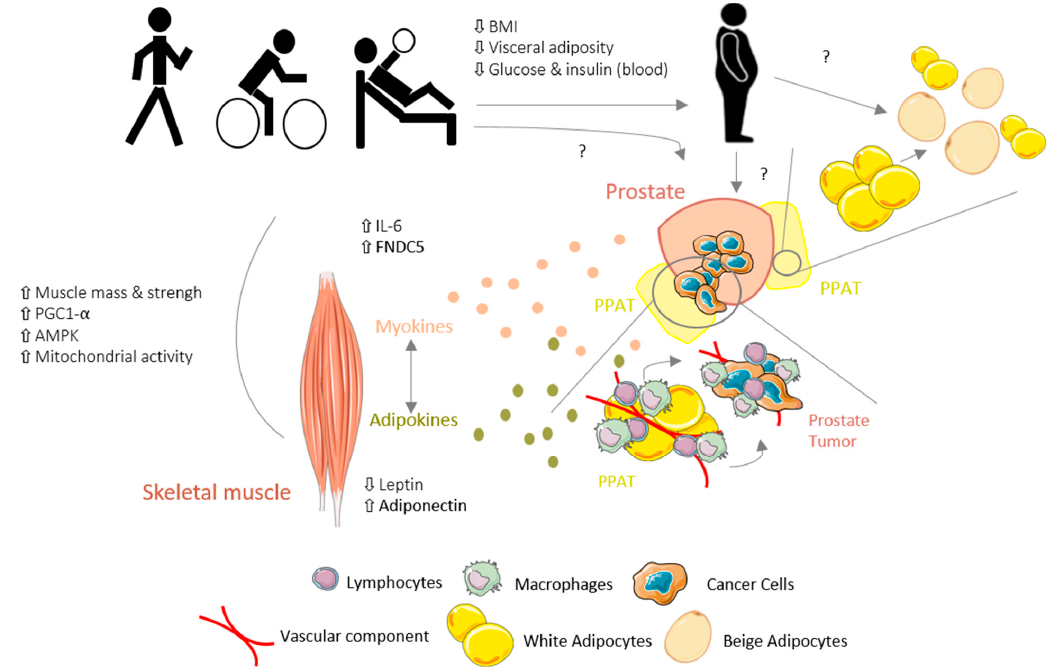
Figure 1. Schematic view of hypothetical mechanisms underlying the effects of exercise training (ET) on the skeletal muscle–white adipose tissue (WAT)–tumor axis in prostate cancer (PCa).ET promotes several positive adaptations in WAT by decreasing the visceral adiposity and increasing the skeletal muscle mass in PCa patients, which is reflected by a positive modulation of the tumor microenvironment (TME). Furthermore, adipokine/myokine production and secretion in response to ET may modulate the skeletal muscle–WAT–tumor axis in cancer. However, the role of ET on PPAT and PCa tumor remains elusive, with conflicting data; BW, body weight; PPAT, periprostatic adipose tissue; PGC-1 α , peroxisome proliferator-activated receptor gamma coactivator; AMPK, adenosine monophosphate-activated protein kinase; IL-6, interleukin-6; FNDC5, fibronectin type III-domain containing 5.